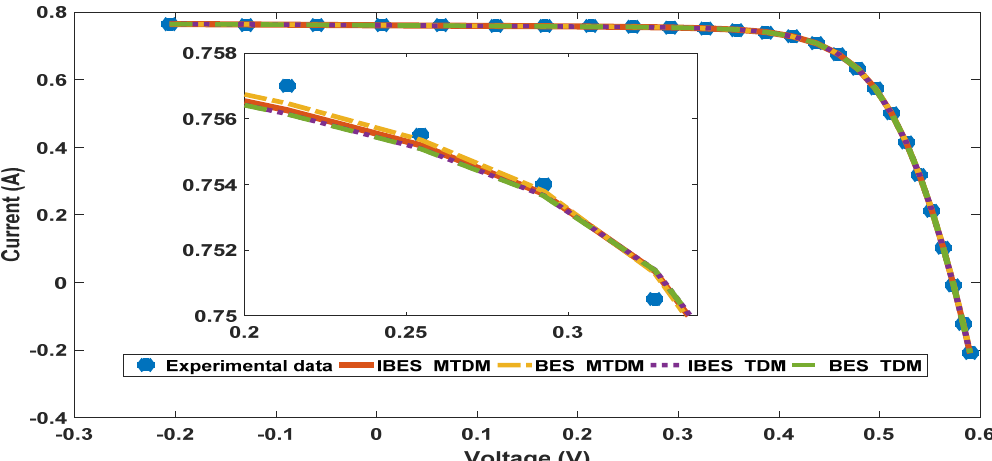
Figure 18. Current–voltage curve for the experimental data and for the MTDM, and TDM currents estimated by the IBES and BES.